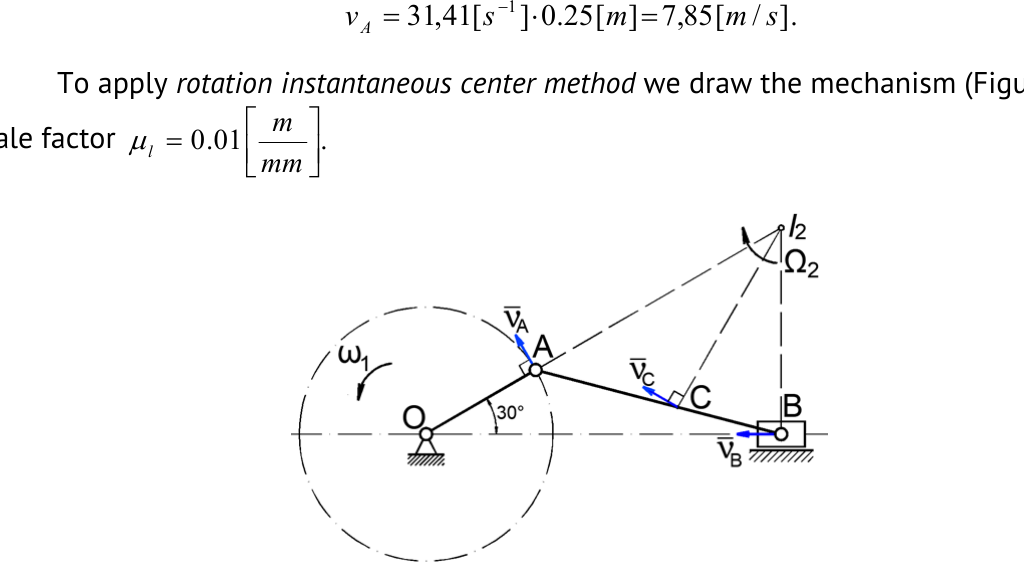
Figure 2. The rotation instantaneous center